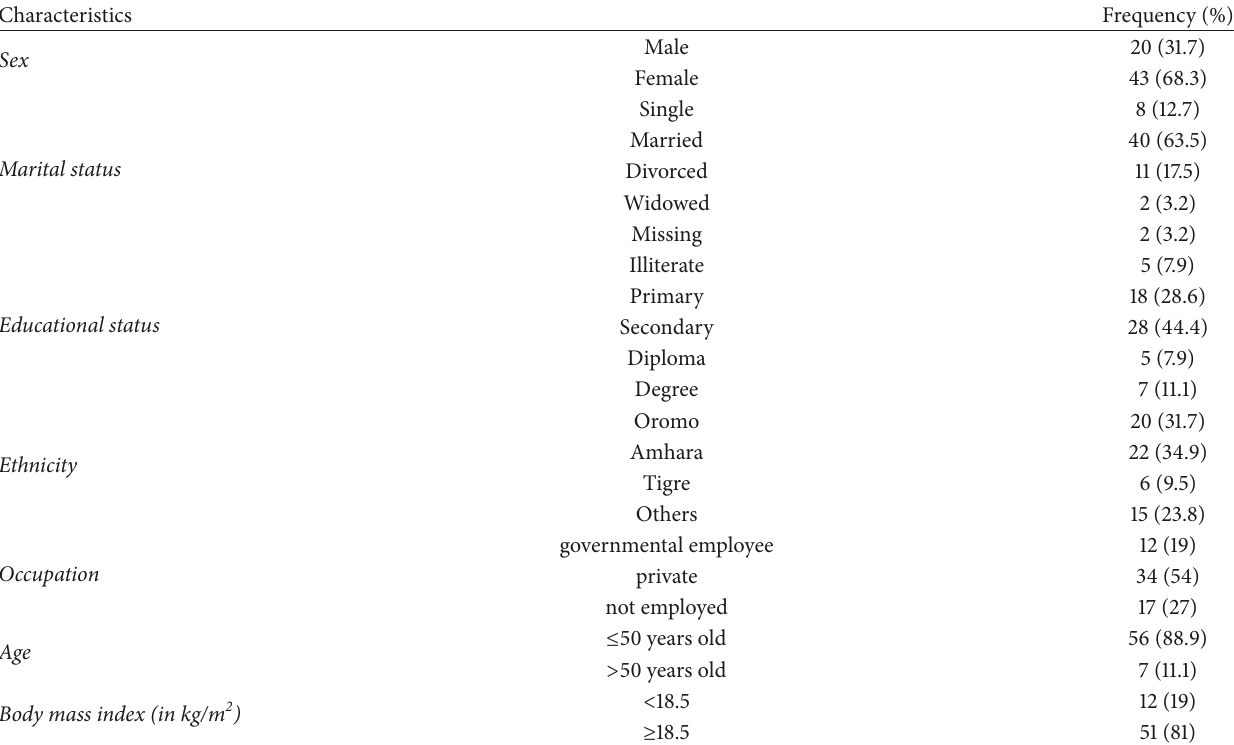
Table 1: Baseline sociodemographic characteristics of study participants in Tikur Anbessa Specialized Hospital (TASH), October 2017 [n =